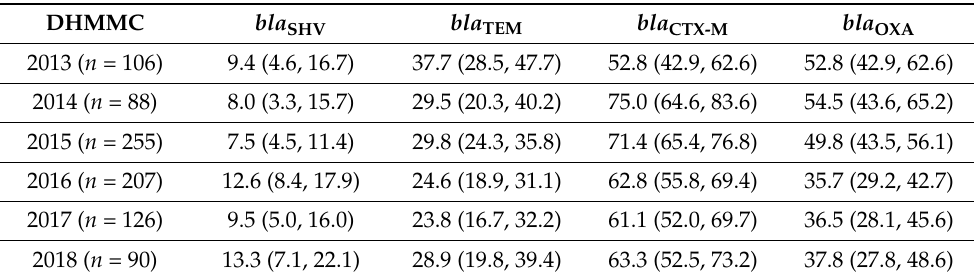
Figure 1. Venn diagrams of bla SHV , bla TEM , bla CTX-M , and bla OXA combinations from both repositories. ( a ) Venn diagram of the resistance genes found in the clinical isolates from DHMMC. There were 142 isolates without any of these resistance genes (inconclusive data). ( b ) Venn diagram of the resistance genes found in the nationwide database of ESBL clinical isolates. Table 1. The yearly frequency of bla SHV , bla TEM , bla CTX-M , and bla OXA from DHMMC. Each frequency is presented with a 95% confidence interval. The number of isolates is given in the first column in